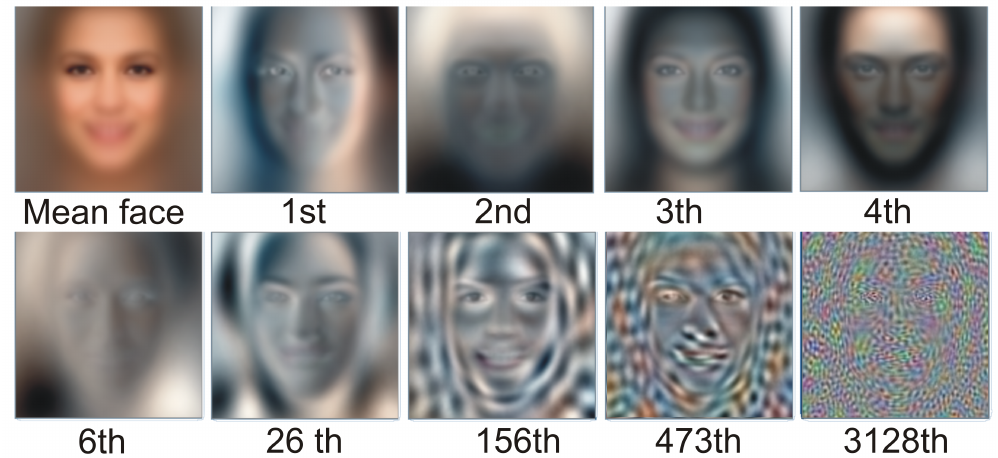
Figure 2. A mean face (in which pixels are averaged values of whole training data set of 50,000 images), then first four eigenfaces, sixth eigenface (six first eigenfaces explains 50% of variance), 26th (26 first eigenfaces explains 75% of variance), 156th (156 first eigenfaces explains 90% of variance), 473rd (473 first eigenfaces explains 95% of variance), and 3128th (3128 first eigenfaces explains 99% of variance).